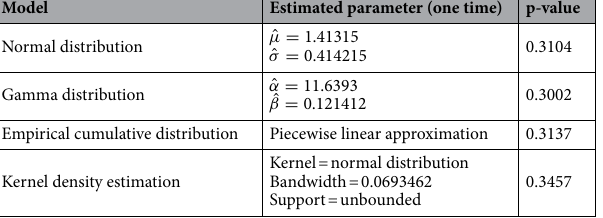
Table 3. The average p-values of the Kolmogorov–Smirnov test for the Kimura model distance data.